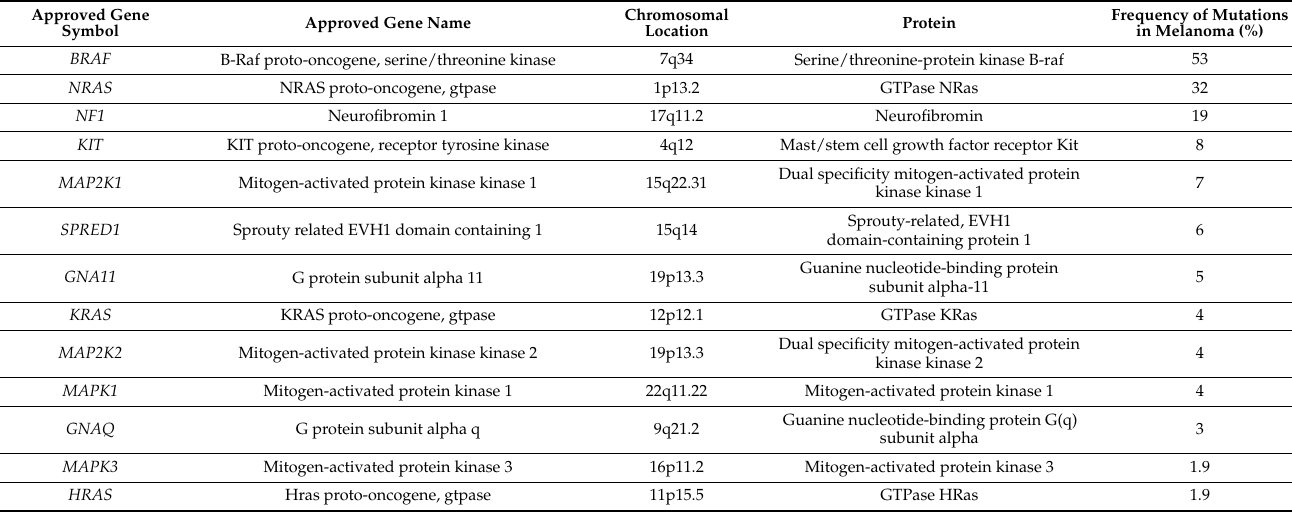
Table 1. Genes from MAPK pathways involved in melanoma pathogenesis